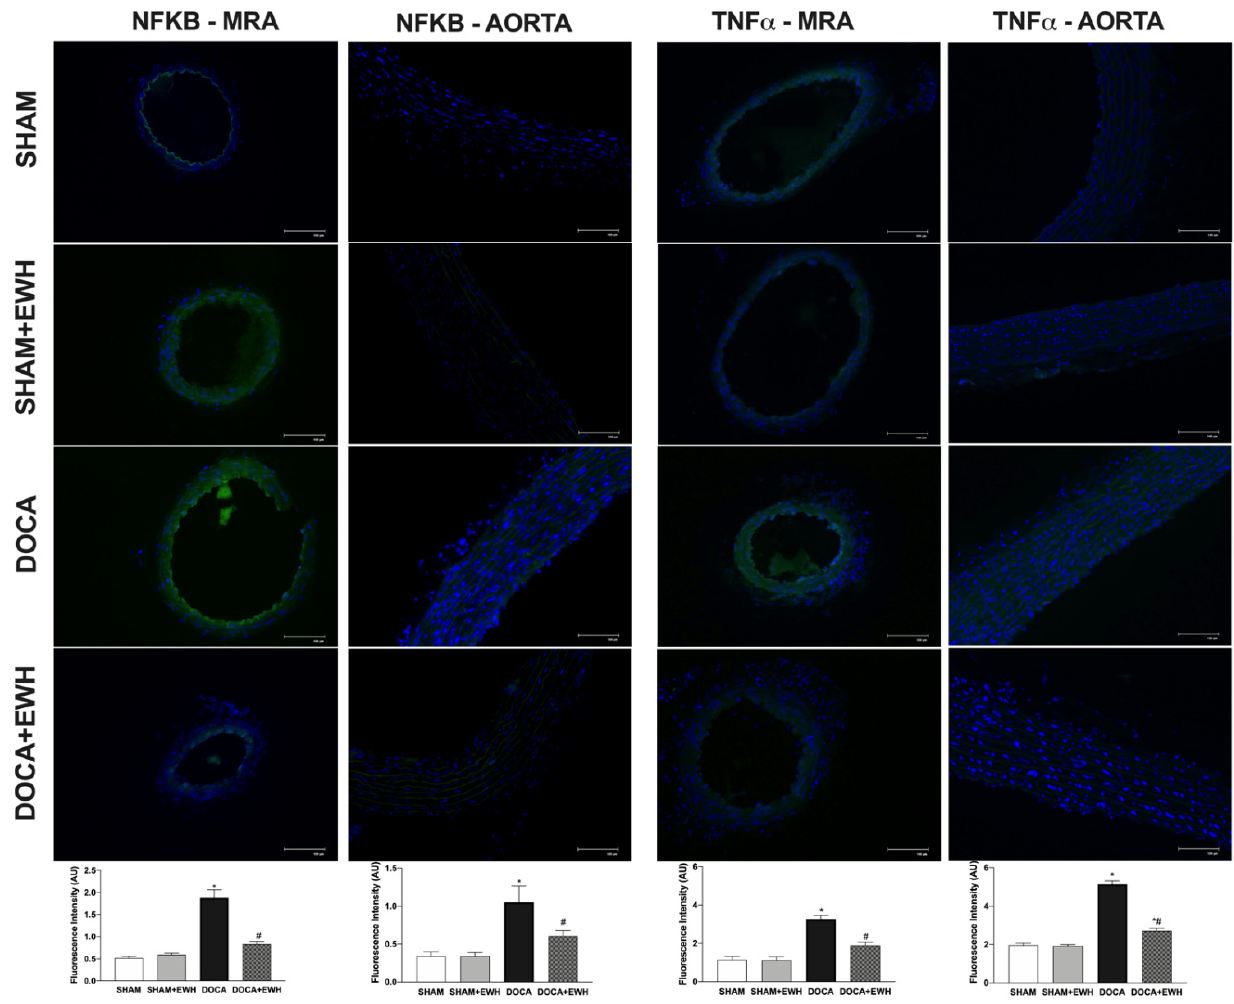
Figure 9. The role of EWH on NF-kB and TNF α expression in MRA and aorta section of DOCA-salt rats. Representative photomicrographs ( × 40 magnification) and histogram of NF-kB (left) and TNF α (right) immunofluorescence of MRA and aorta sections of SHAM, SHAM+EWH, DOCA, and DOCA+EWH arteries. Data are expressed as mean ± SEM, n = 8. The images correspond to the merge of the marking of the colors by the DAPI in blue and the NF-kB and TNF α in green. Two-way ANOVA followed by Bonferroni post-test: p < 0.05 * vs. SHAM; # vs. DOCA.